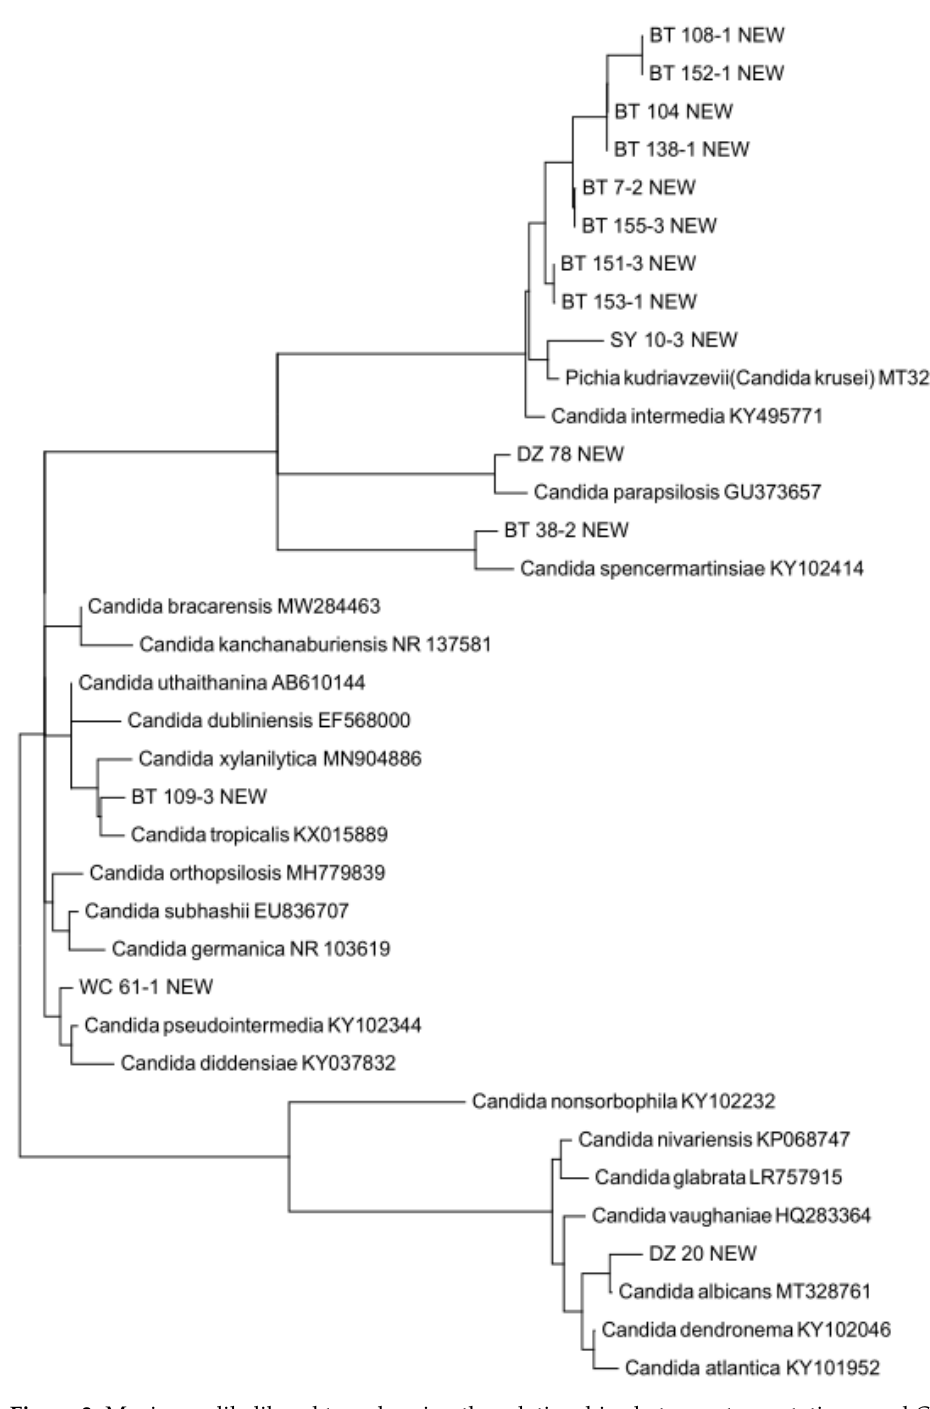
Figure 3. Maximum likelihood tree showing the relationships between ten putative novel Candida species and their closely related known species based on rDNA ITS sequences. The geographic origins of these putative novel species are indicated as two-letter abbreviations, where BT = Baoting, DZ = Danzhou, and WC = Wenchang. The tree was constructed using RaxML with 1000 bootstraps.